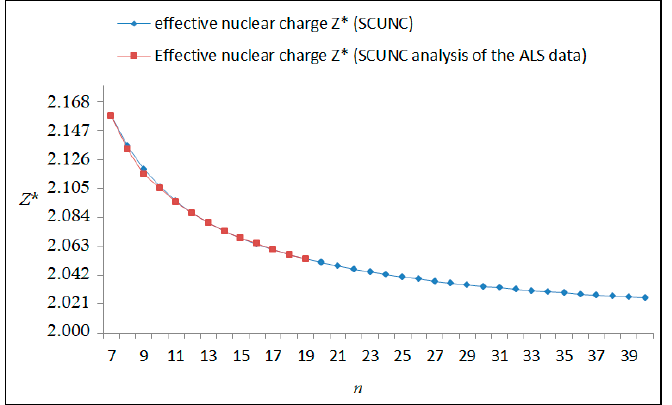
Figure 8. Variations of the effective nuclear charge Z* with the principal quantum number n for the 4 s 2 4 p 2 ( 3 P 2 ) nd Rydberg series originating from the 2 P ° 3/2 metastable state of Se + converging to the 1 D 2 series limits in Se 2+ . ** Energy differences relative to the ALS experimental data. Table 5. Energy resonances ( E ), quantum defect ( δ ) and effective charge ( Z *) of the 4 s 2 4 p 2 ( 1 D 2 ) nd ( 2 P 1/2 ) Rydberg series originating from the 4 s 2 4 p 3 2 P° 1/2 metastable state of Se + converging to the 1 D 2 series limit in Se 2+ . The present results (SCUNC) are compared with the experimental data from ALS measurements [6]. The uncertainties in the experimental energies are stated to be ±0.010 eV, f 1 ( 1 D 2 ; 2 P 1/2 ; 2 P ° 1/2 ) = − 0.301 ± 0.032 with ν = 6.